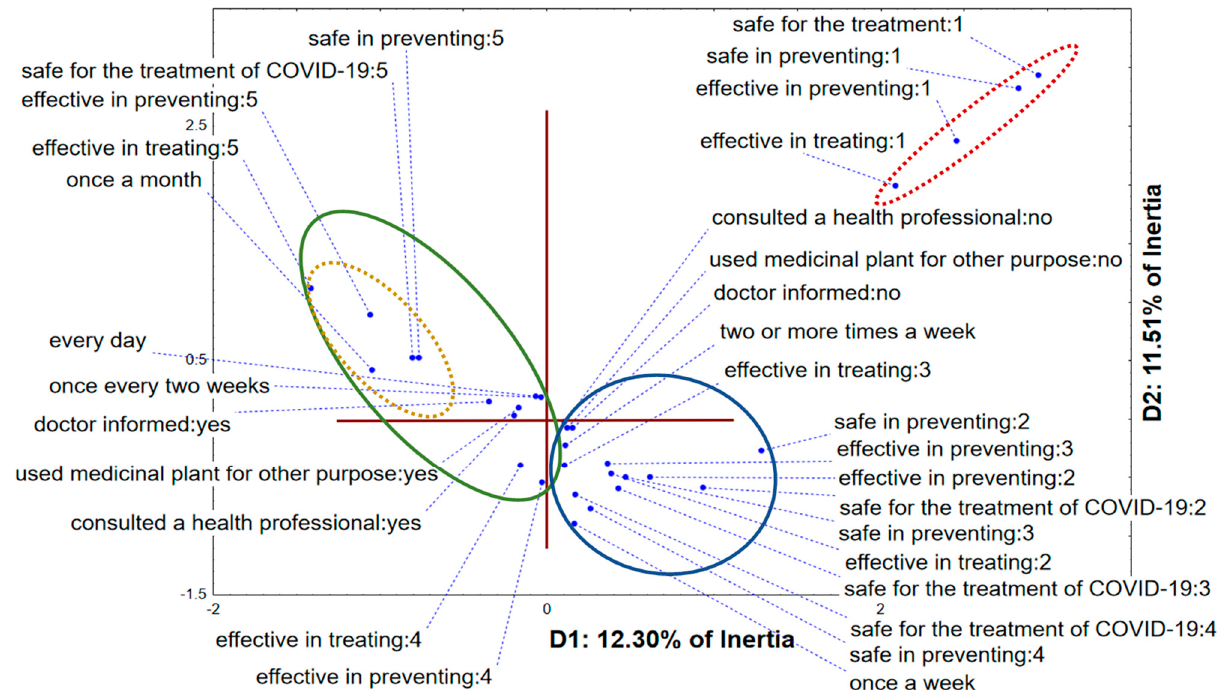
Figure 2. Multiple correspondence analysis—medicinal plants usage. The position of recorded respondents’ answers in the space defined by the first two dimensions.